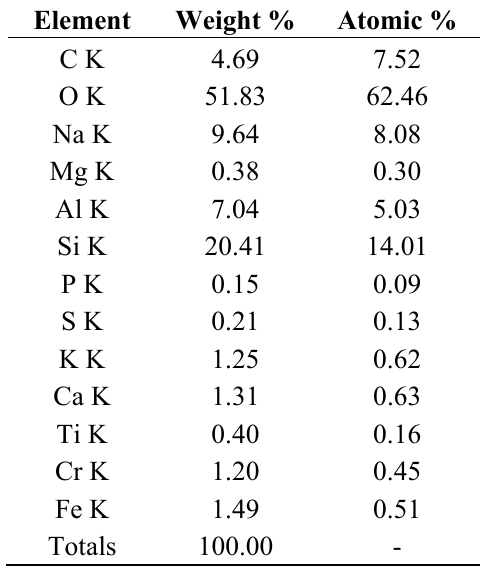
Table 3. Spectrum 1, elemental analysis performed on the area delimited by the white